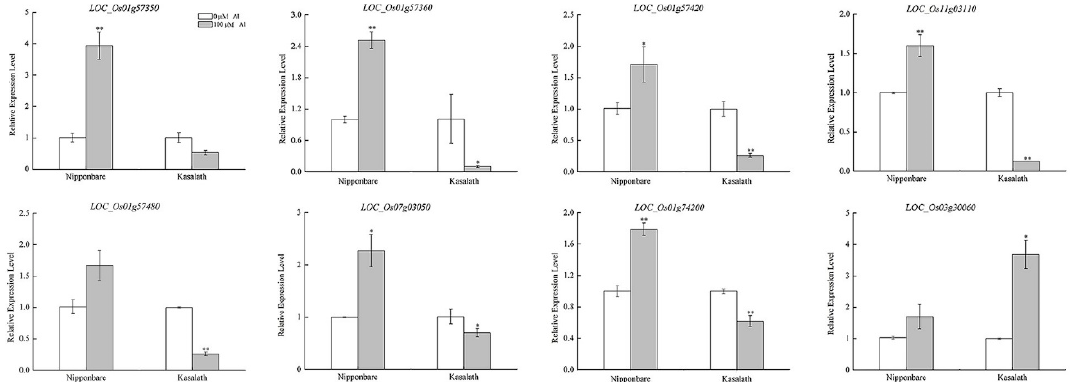
Figure 7. Expression of eight candidate genes in the rice root tip. * and ** represent significant differences at the p < 0.05 and p < 0.01 levels ( t -test), respectively.